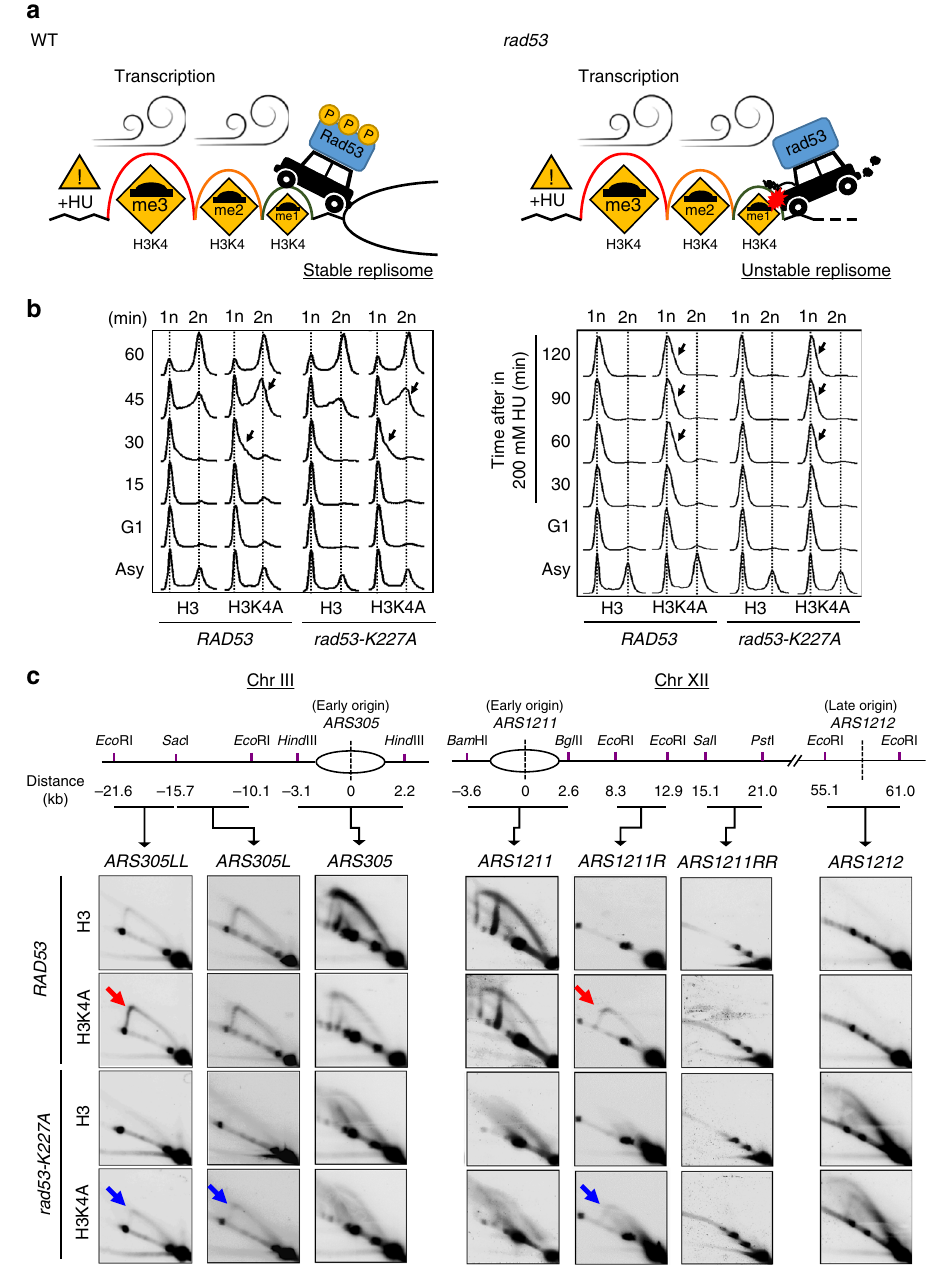
Fig. 6 H3K4 methylation deposited by transcription decelerates replication forks. a A graphic depiction of the “ speed bump model ” . Sites of H3K4 methylation deposited by transcriptional activity act as “ speed bumps ” for active replication forks (represented by the black car), while activation of Rad53 checkpoint kinase maintains the stability of replisomes during replication stress. In the absence of checkpoint activity, such as in rad53 -mutant cells, H3K4 methylation becomes an impediment to replication and destabilizes the replisome. The red explosion drawing indicates the stalling of replication forks. b FACS pro fi les of RAD53 -H3, RAD53 -H3K4A, rad53-K227A- H3, and rad53-K227A -H3K4A cells released from G1 into rich medium without (left) or with 200 mM HU (right) at indicated time points. Black arrows indicate faster S-phase progression or DNA duplication in H3K4A cells compared to H3 cells. c 2D gel analysis of RAD53 -H3, RAD53 -H3K4A, rad53-K227A- H3, and rad53-K227A -H3K4A cells. Replication intermediates from indicated regions of chromosomes III and XII from ARS305 and ASR1211 were identi fi ed in the indicated strains following G1 synchronization and release into 200 mM HU for 1 h. The arrows mark Y-arc signals that represent duplicating replication forks in RAD53 -H3K4A and rad53K227A -H3K4A cells. Bubble-arc signals at ARS1212 indicate the late origin was repressed in RAD53 and activated in rad53-K227A